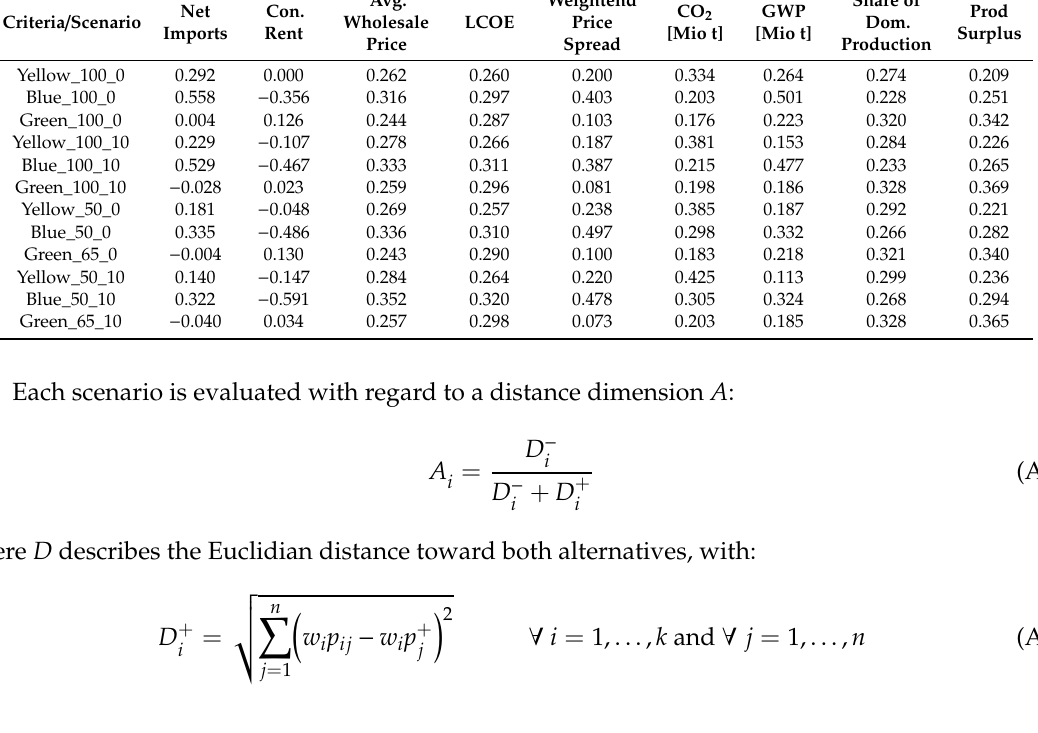
Table A1. Normalized MCDA criteria. Source: own calculation. Criteria /